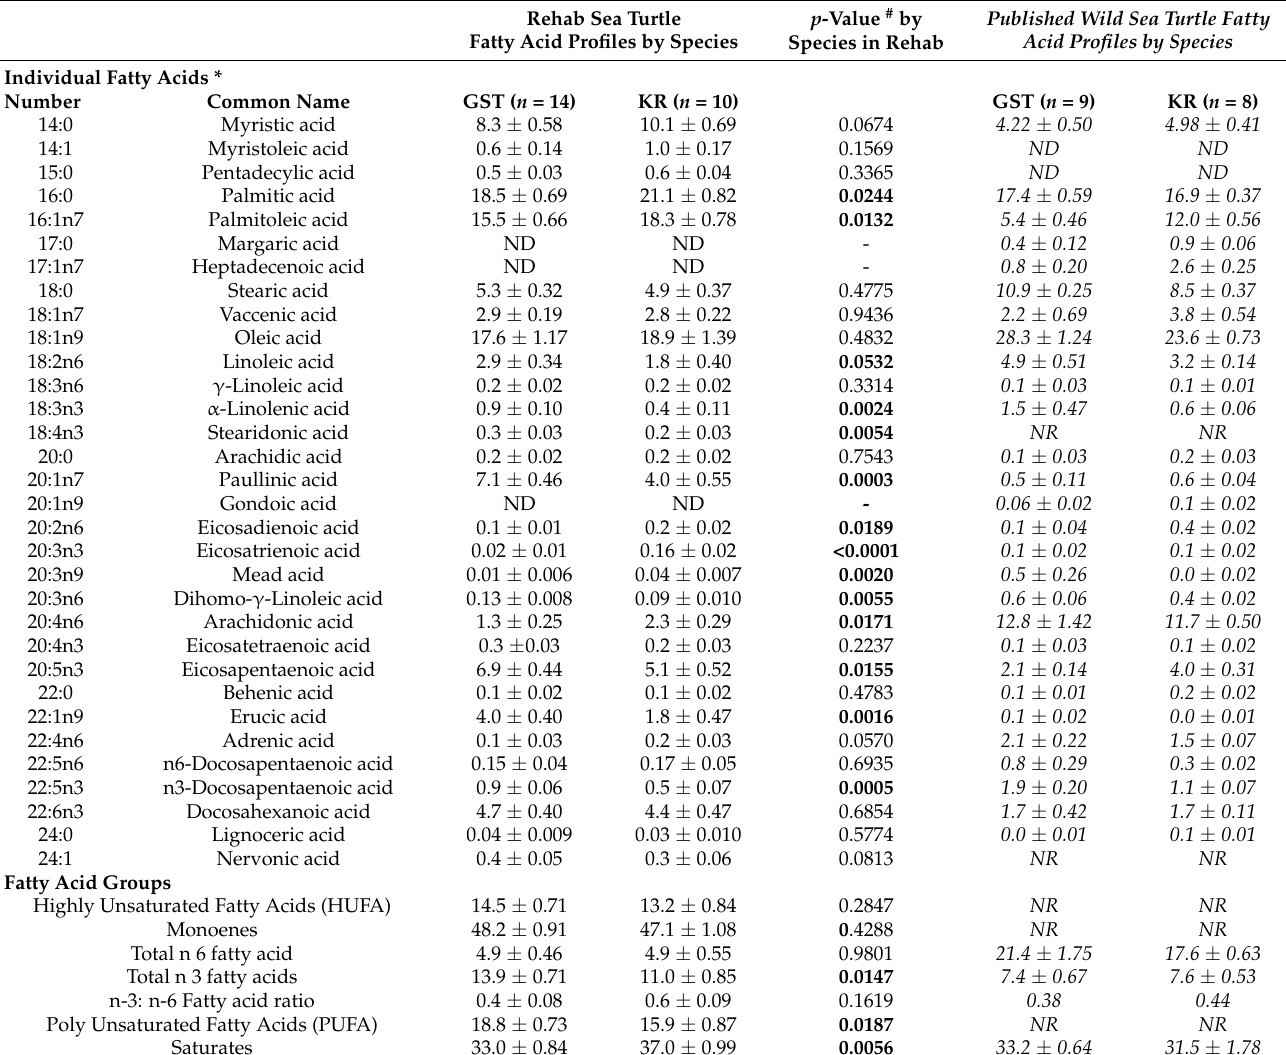
Table 2. Total whole-blood individual and fatty acid grouping profiles (%, mean ± SEM) for juvenile green (GST; Chelonia mydas) and Kemp’s ridley (KR; Lepidochelys kempii ) turtles in rehabilitation (rehab) housing compared to published wild juvenile turtle data [15] 1